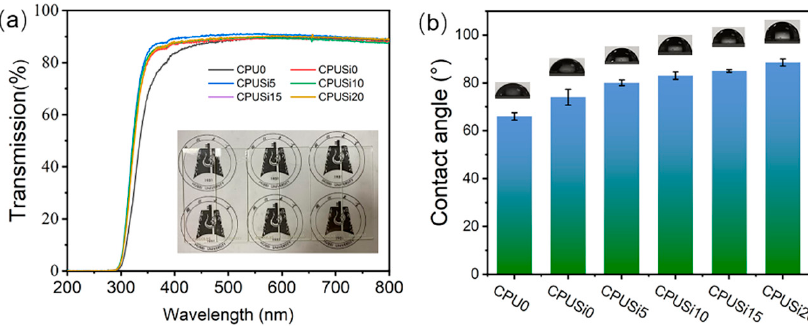
Figure 7. ( a ) The transmittance; ( b ) Water contact angle of CPU and CPUSi hybrids films.